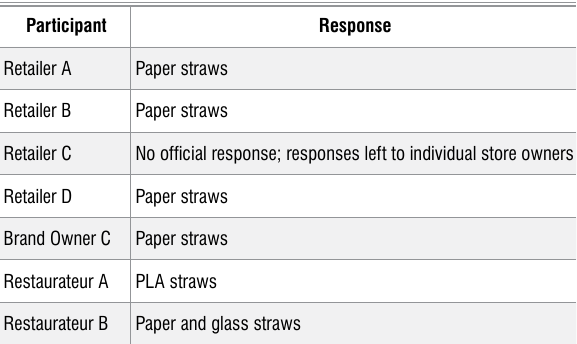
Responses of the value-chain actors interviewed